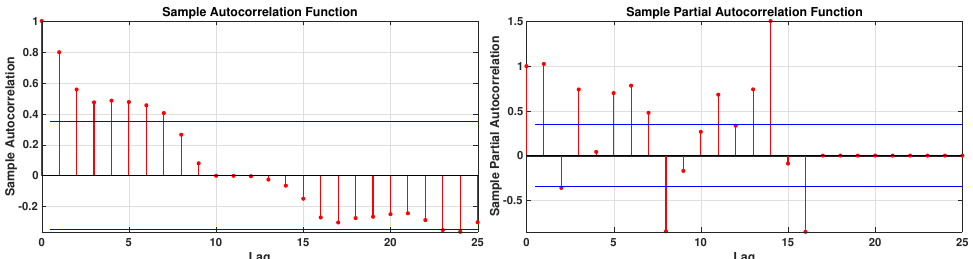
Figure 12. Autocorrelation Function (ACF) (left hand side) and Partial Autocorrelation Function (PACF) (right hand side) applied to the daily number of cases for Japan between 19 October and